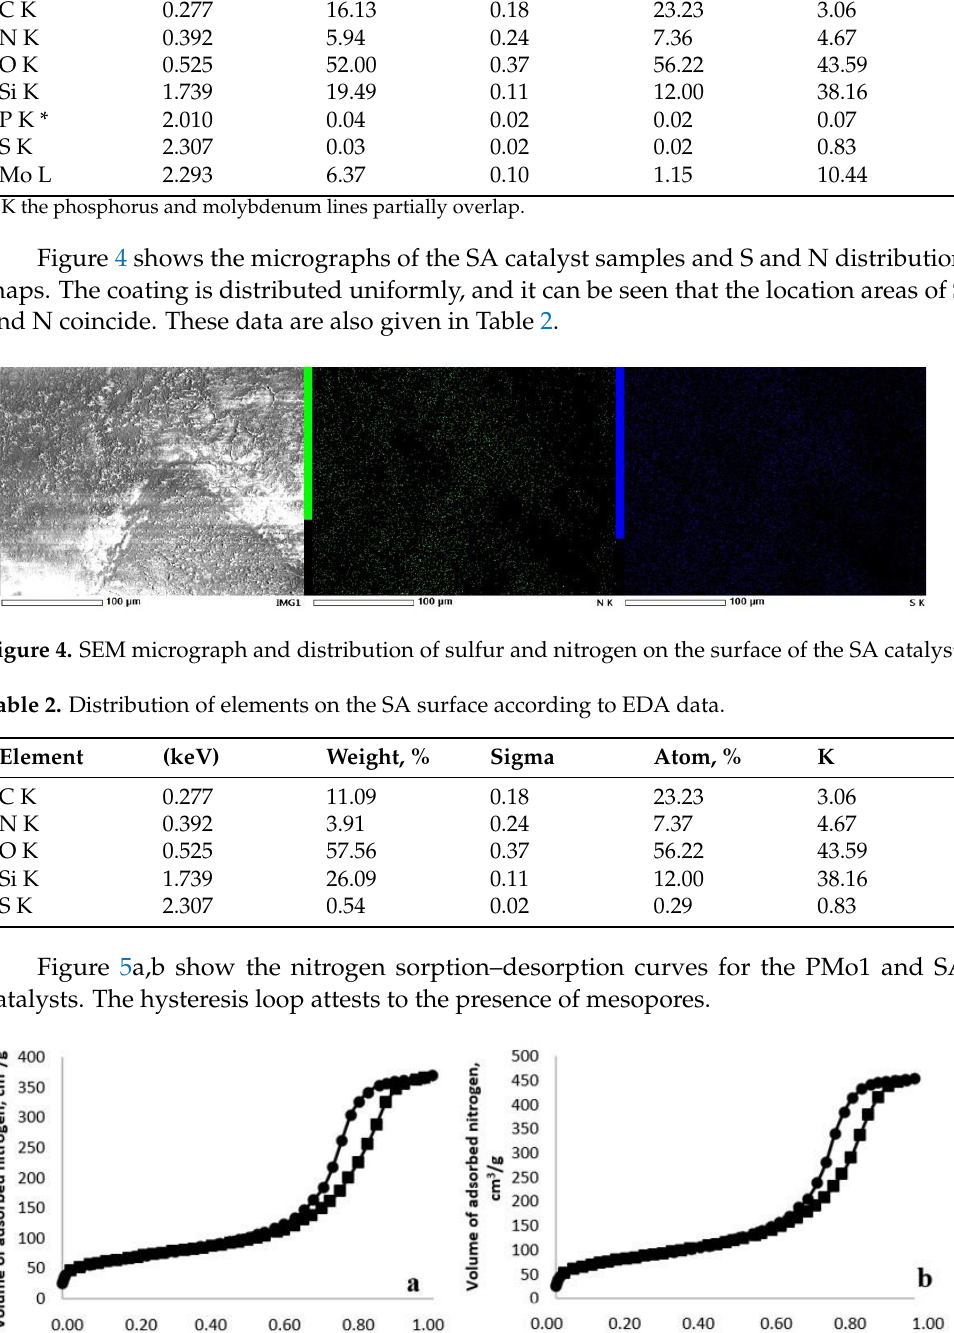
Figure 3. SEM micrograph and distribution of sulfur, phosphorus, and molybdenum on the surface of the PMo1 molybdenum catalyst.